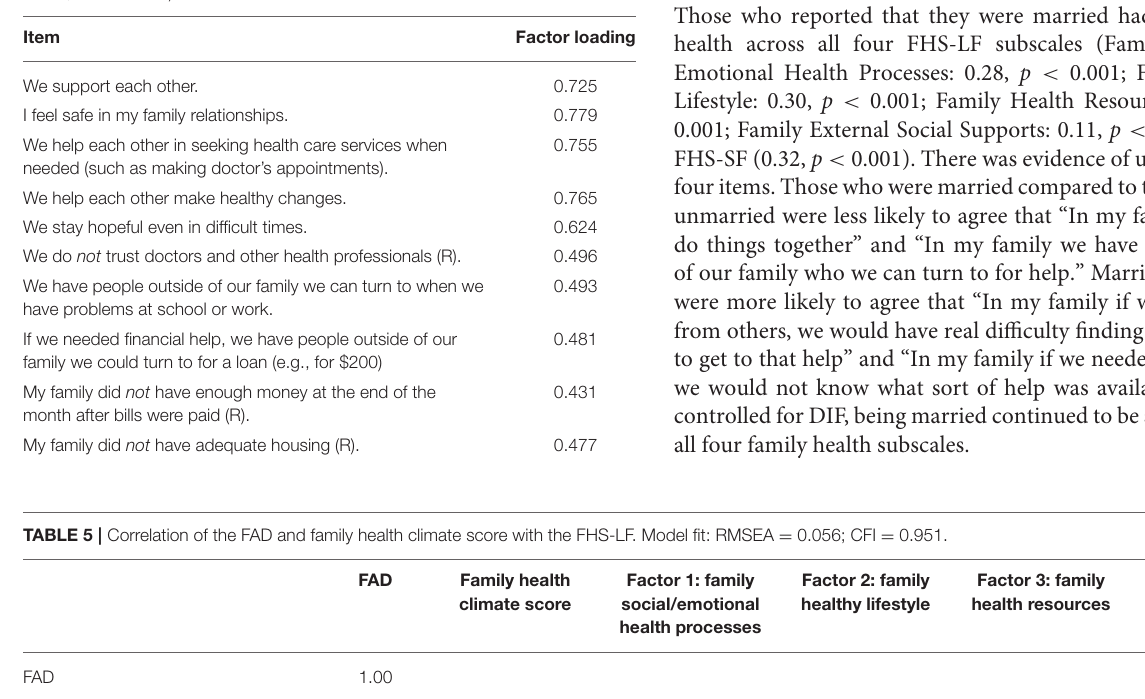
TABLE 4 | Confirmatory factor analysis results of the FHS-SF, n = 350 (RMSEA = 0.060; CFI = 0.986).